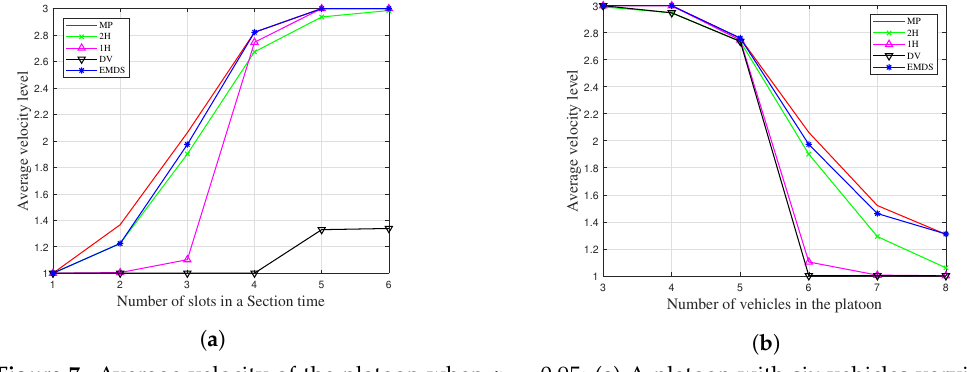
Figure 7. Average velocity of the platoon when α = 0.95; ( a ) A platoon with six vehicles varying the number of slots ( M ) in a section time and ( b ) Three slots in a section time varying the number of vehicles ( N ) in the